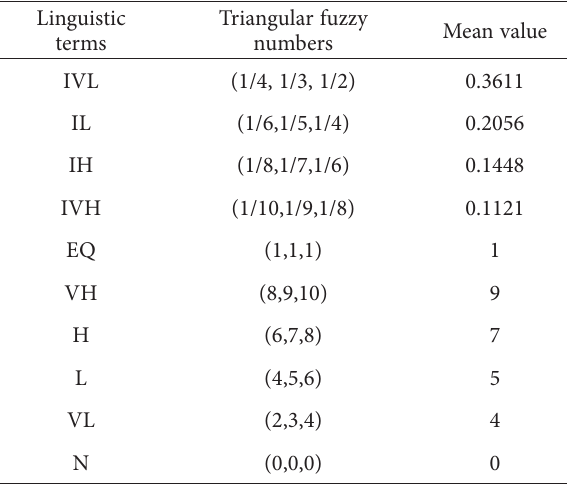
Table 1. The fuzzy linguistic scale for the experts’